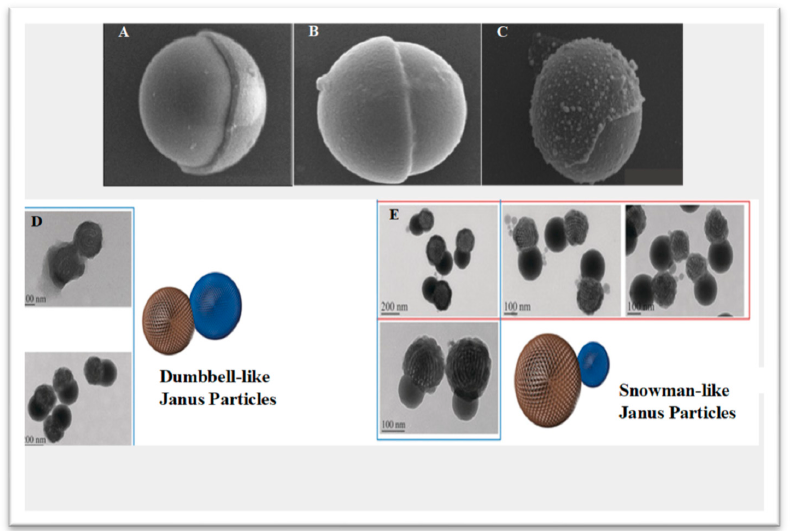
Figure 1. Anisotropic Janus particles with a variety of structural conformations. ( A – C ) SEM images of various spherical Janus particles and ( D , E ) TEM images of dumbbell-like and snowman-like Janus particles. Reproduced with permission from [19], © Wiley (2017) and © Royal Society of Chemistry (2010).